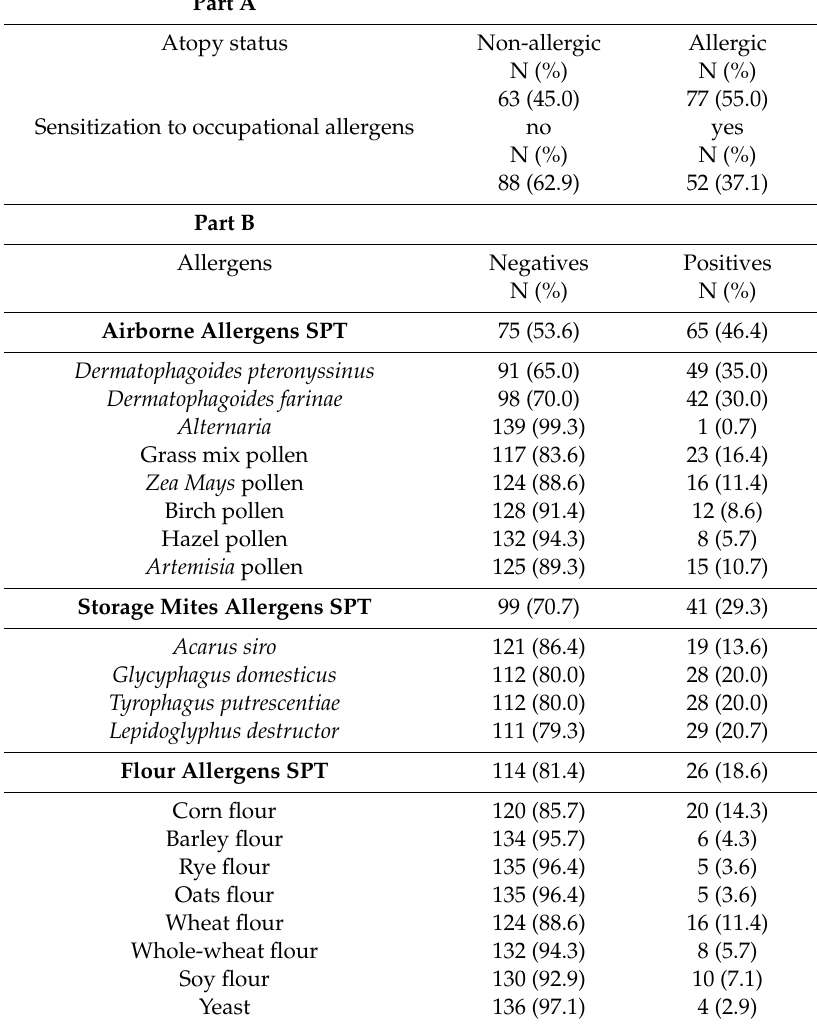
Table 2. Skin prick test results.